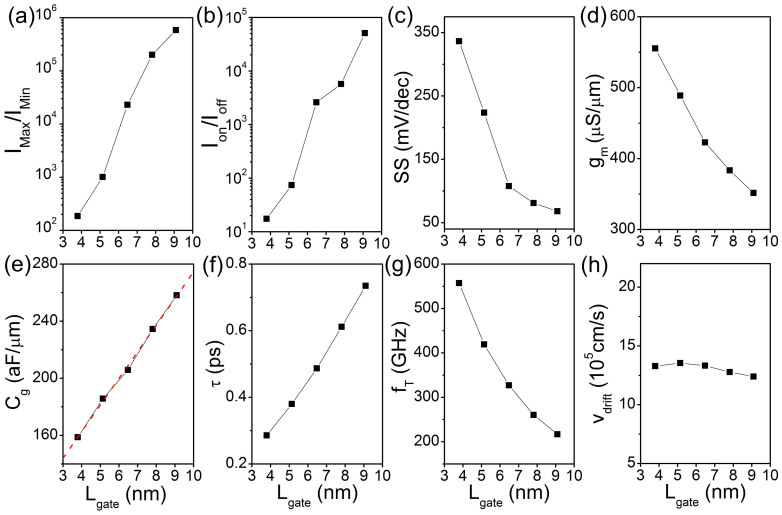
Critical device performance parameters of the SNM field effect transistors as a function of the gate length at Vbias = 0.2 V: (a) Imax/Imin current ratio, (b) on/off current ratio at a gate voltage window of 0.5 V, (c) subthreshold swing, (d) transconductance, (e) intrinsic gate capacitance, (f) charge carrier transit time, (g) intrinsic cut-off frequency, and (h) carrier drift velocity.